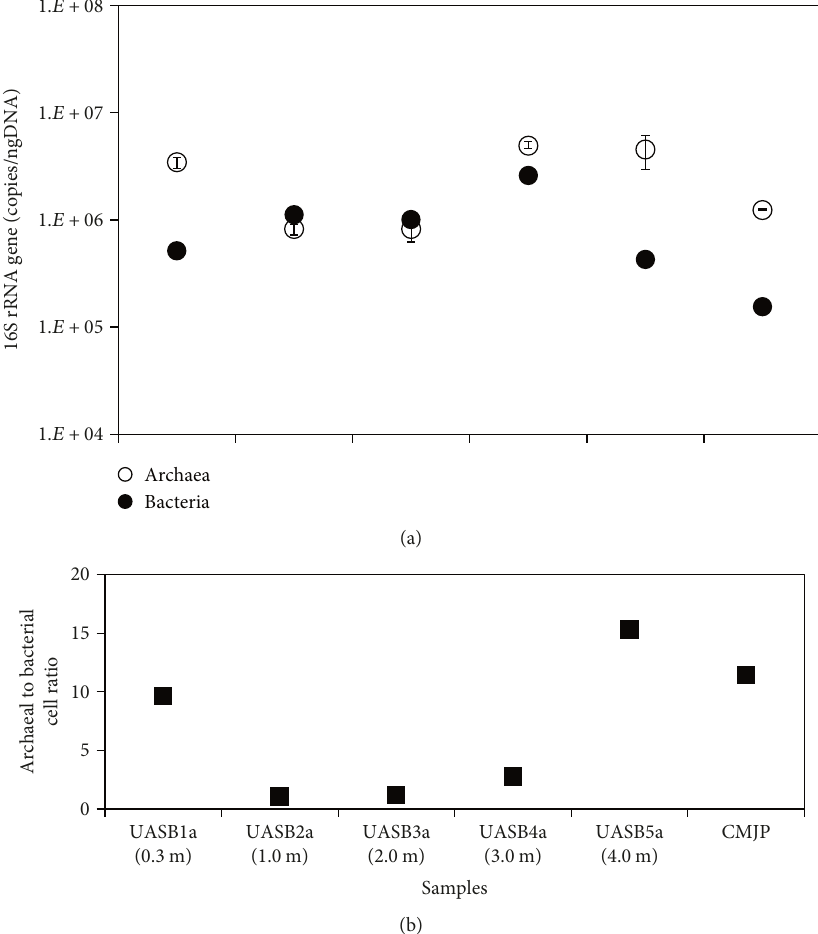
Figure 4: (a) 16S rRNA gene copies (on average) of archaeal and bacterial populations and (b) the estimated ratios of archaeal to bacterial populations in methanogenic sludge from tetramethylammonium-degrading CMSS (sample CMJP) and UASB reactors (samples UASB1a- UASB5a). Coe ffi cients of variance (CV) for archaeal and bacterial Q-PCR experiments (triplicate analysis per sample) are 1.4 ~ 35.1% and 2.3 ~ 12.8%,